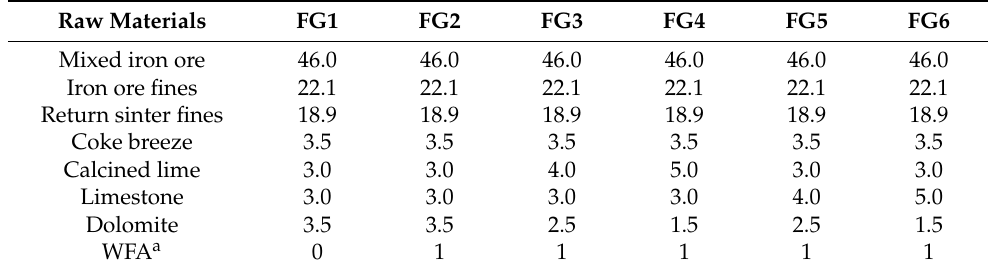
Table 3. The mass ratio of all raw materials (mass, %).